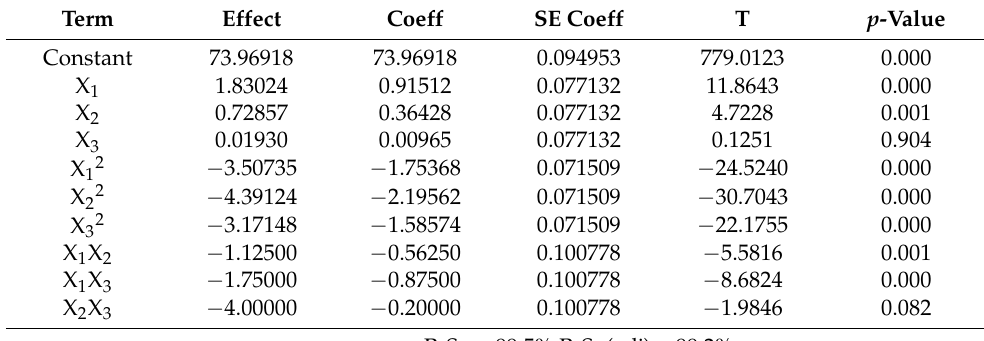
Table 6. Effect estimates and coefficients for the CEC central composite design.